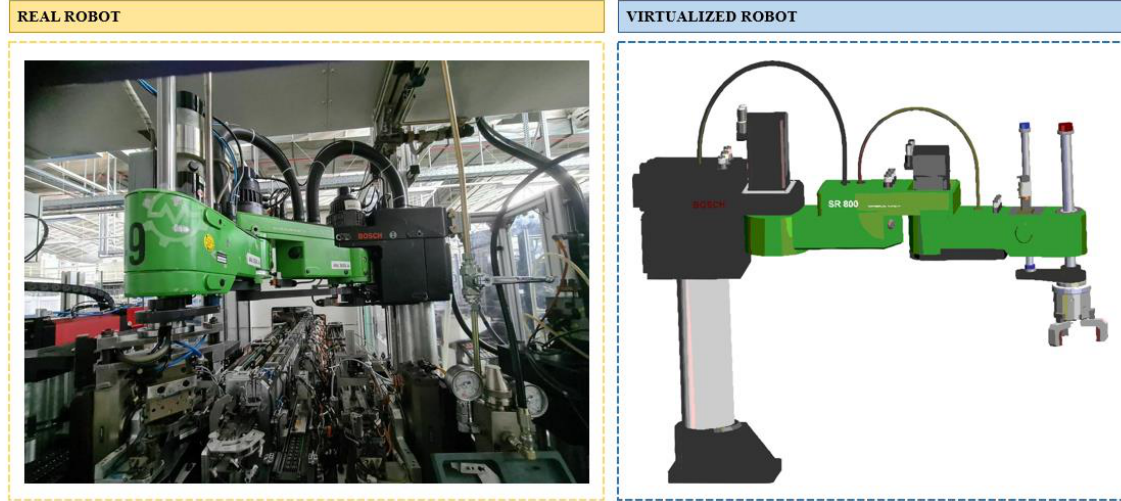
Figure 4. Virtualization of the Scara SR-800 robot.